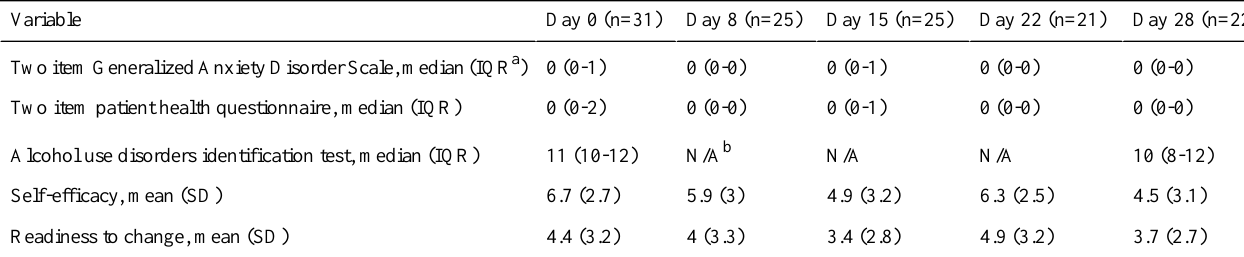
Table 6. Self-reported baseline and weekly measurement